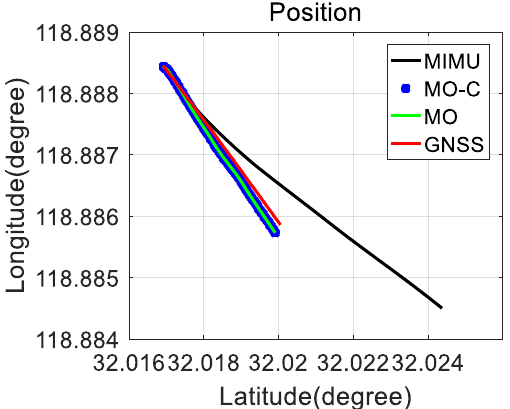
Figure 4. The trajectory from different methods.